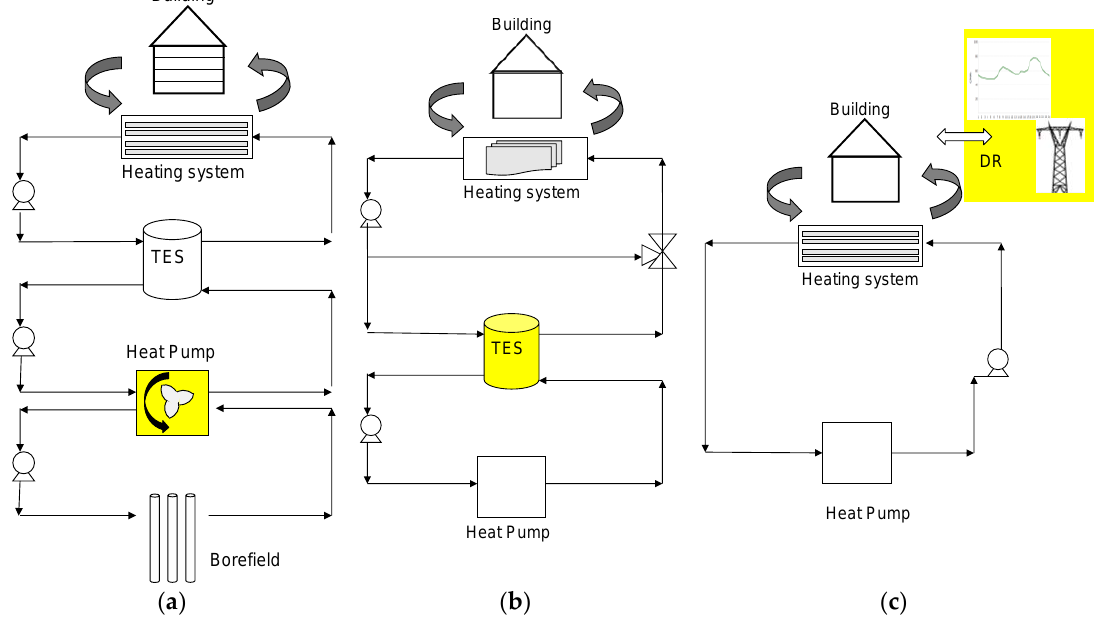
Figure 2. Schematics of the three case studies: ( a ) Case A: energy efficiency, ( b ) Case B: thermal storage, ( c ) Case C: demand response. TES = thermal energy storage; DR = demand response.